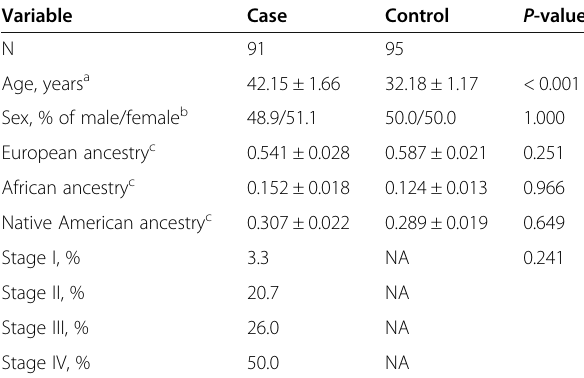
Table 2 Demographic data for case (gastric cancer patients) and control